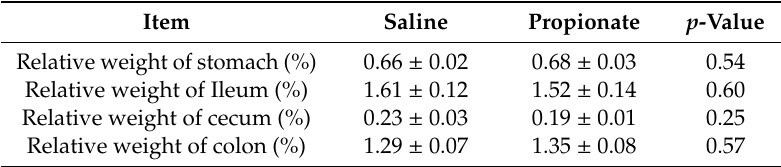
Table 3. E ff ects of the cecal infusion of sodium propionate on the intestinal index.